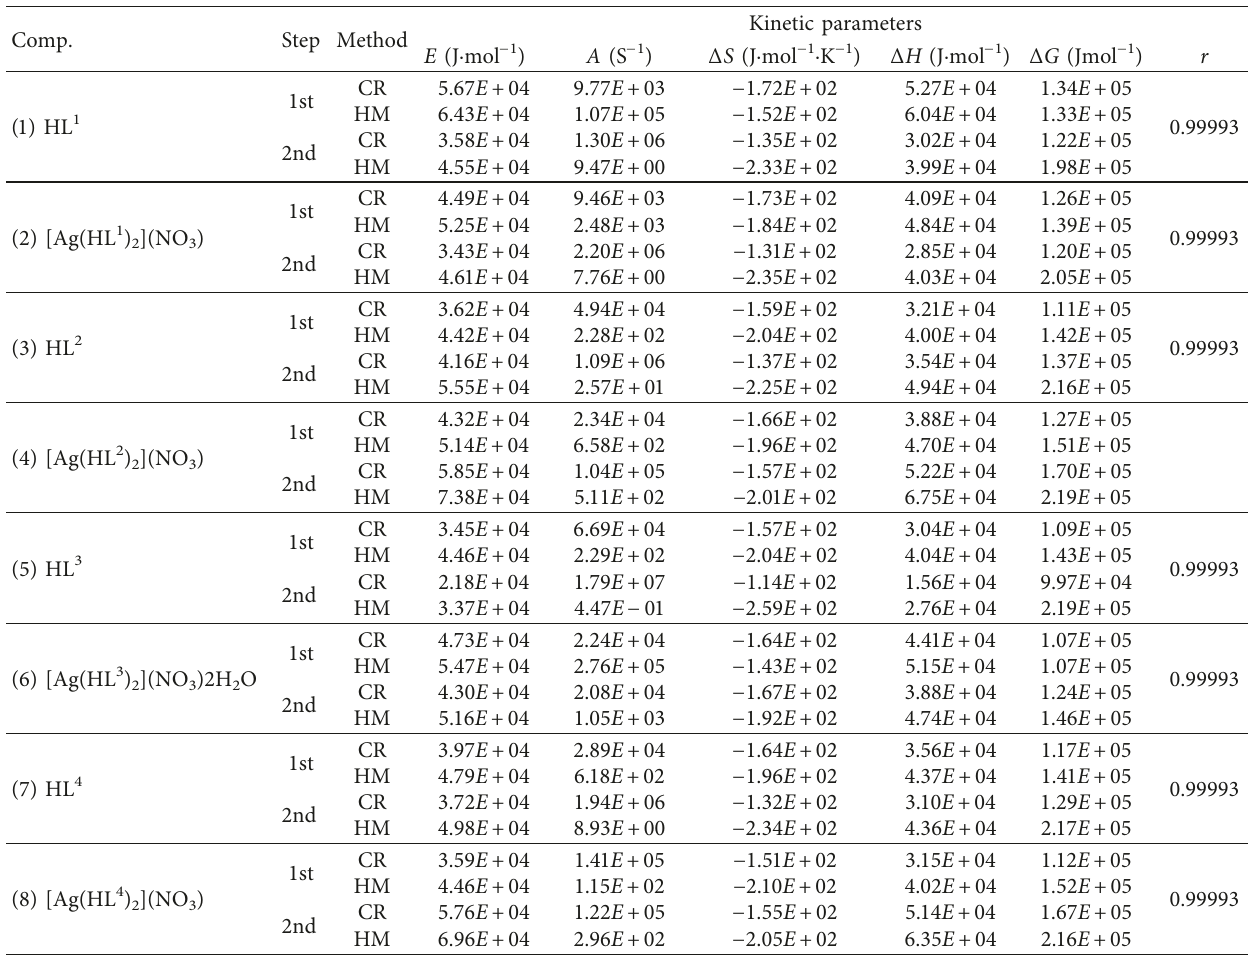
Table 5: Kinetic parameters by using Coats–Redfern (CR) and Horowitz–Metzger (HM) methods.